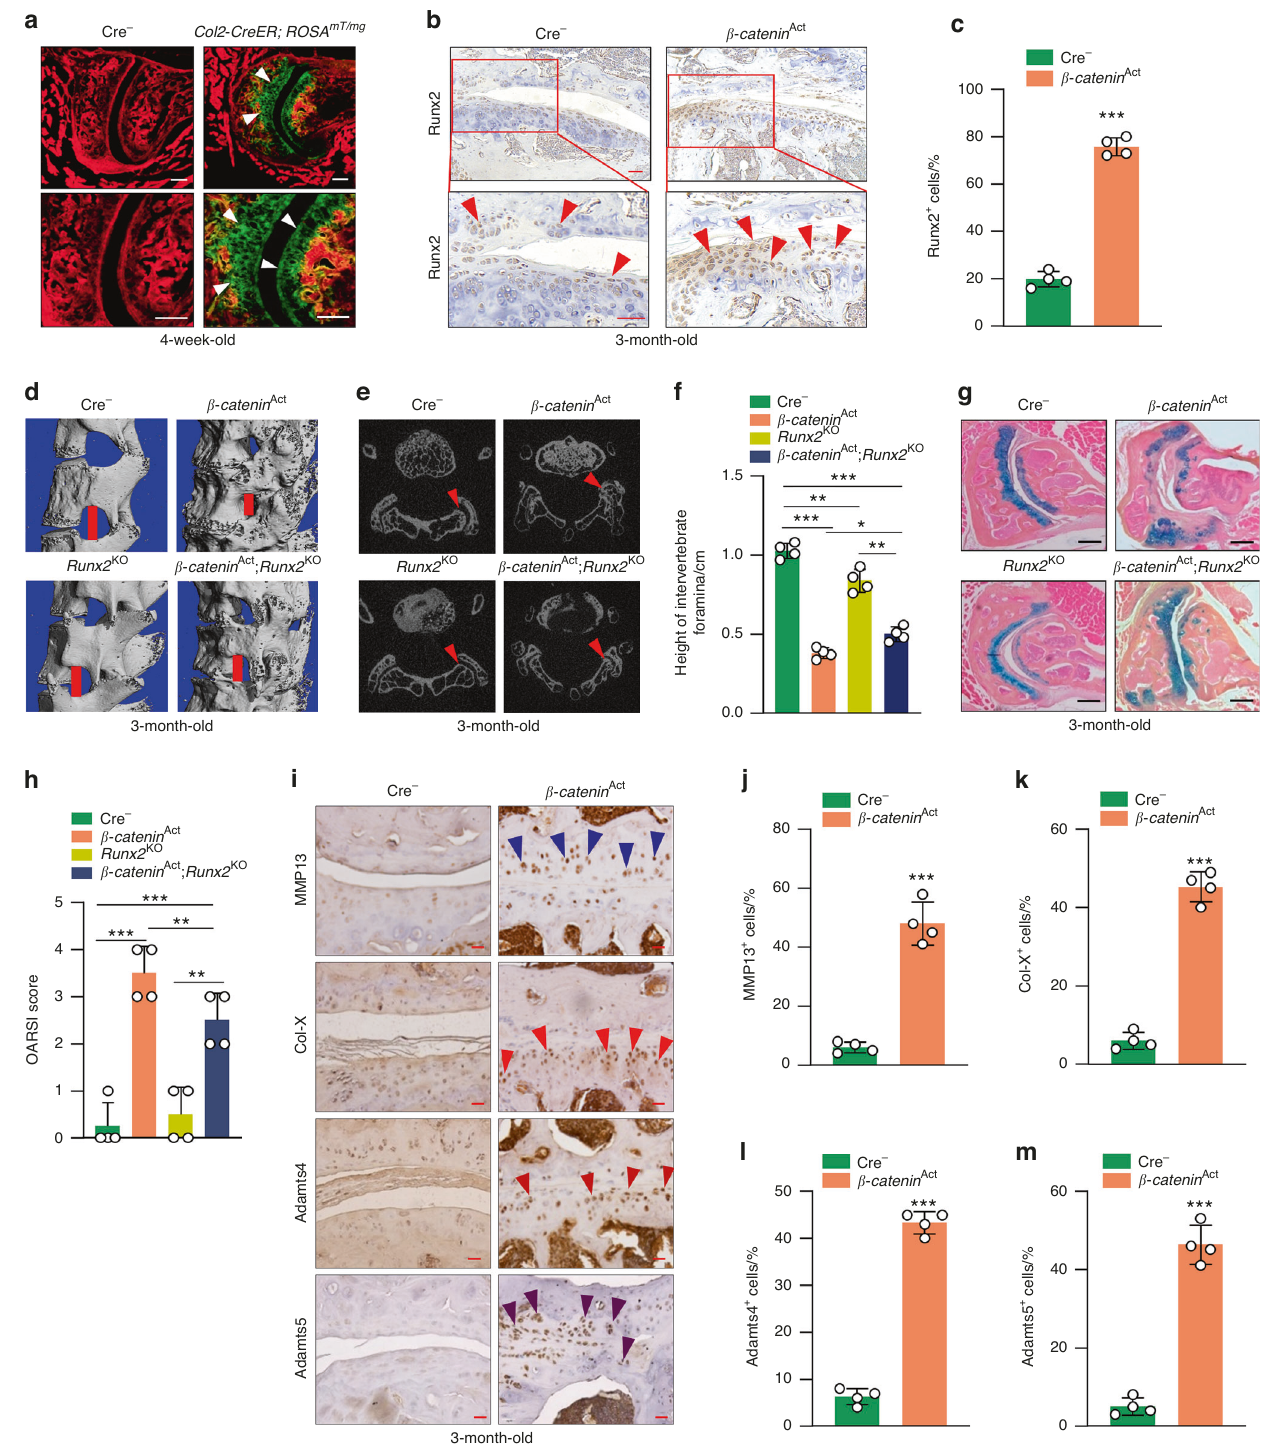
Fig. 4 Severe facet joint osteoarthritis in β -catenin activation transgenic mice. a Representative IF images showing Col2-CreER targeting in articular cartilage of the facet joint ( n = 4) (scale bar 50 μ m). Arrowheads indicate articular cartilage of the facet joint. b , c Representative IHC images showing expression of Runx2 + in the facet joint in 3-month-old β -catenin Act mice and their Cre − littermates ( n = 4) (scale bar 15 μ m). d – f Representative μ CT images showing osteophyte formation ( d ), joint space narrowing ( e ) and the height of intervertebral foramina ( f ) in 3-month-old β -catenin Act mice, Runx2 KO mice, β -catenin Act ; Runx2 KO mice and their Cre − littermates ( n = 4). g , h Representative Alcian blue/ hematoxylin staining (scale bar 30 μ m) showing histomorphometric changes ( g ) and OARSI scores ( h ) in the facet joint in 3-month-old β -catenin Act mice, Runx2 KO mice, β -catenin Act ; Runx2 KO mice and their Cre − littermates ( n = 4). i – m Representative IHC images ( i ) (scale bar 15 μ m) showing the expression of MMP13 + ( j ), Col-X + ( k ), Adamts4 + ( l ) and Adamts5 + ( m ) cells in the facet joint in 3-month-old β -catenin Act mice and their Cre − littermates ( n = 4). * P < 0.05; ** P < 0.01; *** P < 0.001. Data are represented as the mean ± SD. Two-tailed unpaired Student ’ s t test analysis ( b , j – m ). One-way ANOVA followed by Tukey ’ s posttest for multiple comparisons ( f , h